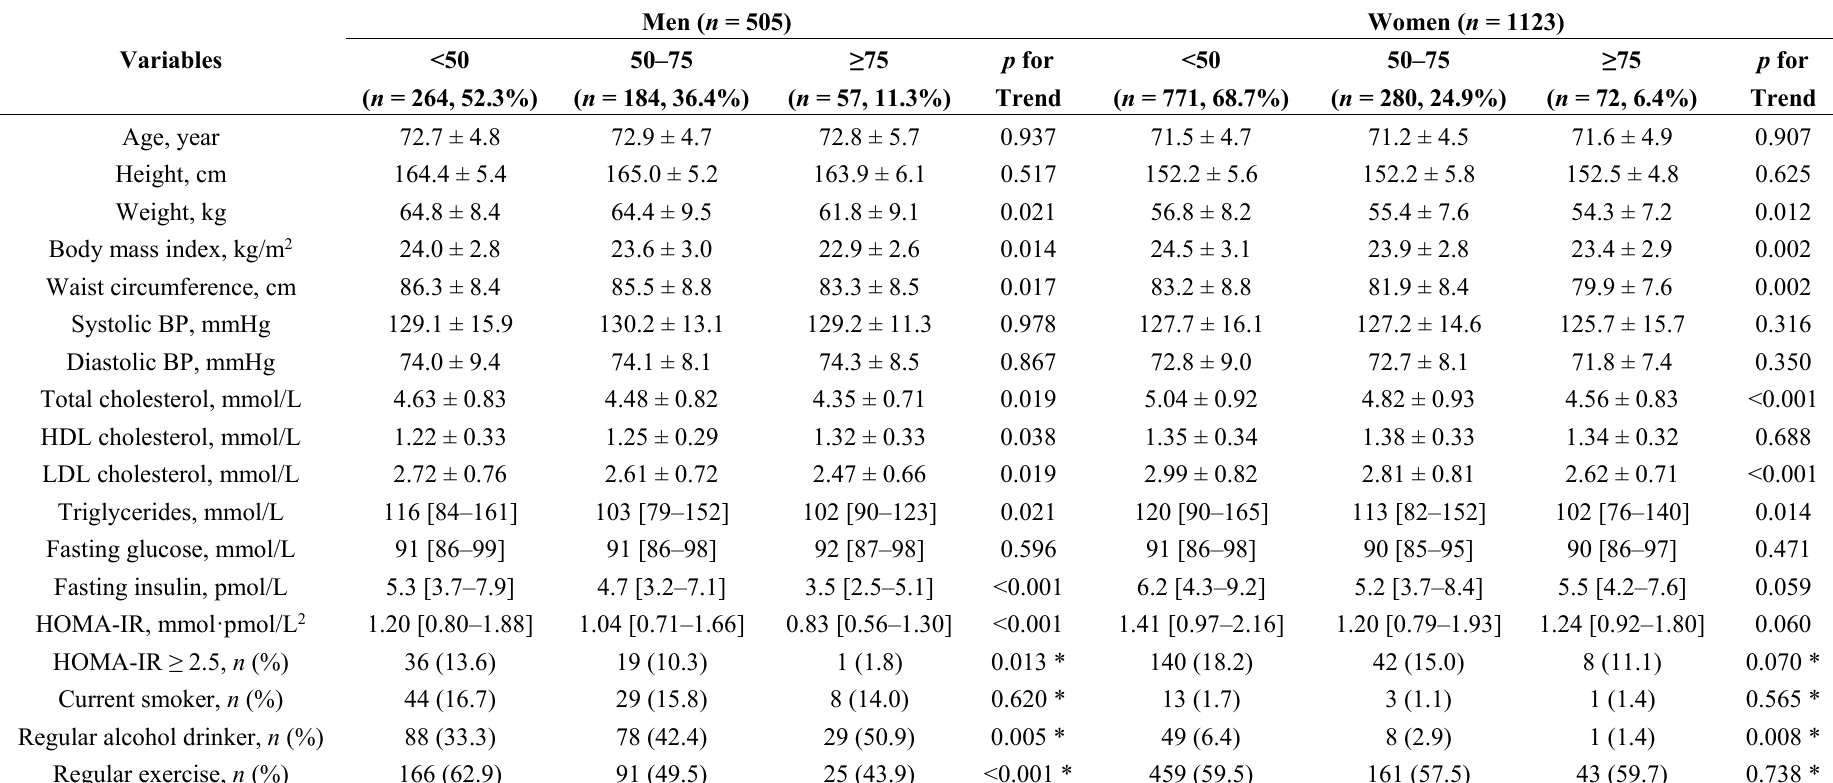
Table 2. Characteristics of the study participants by vitamin D